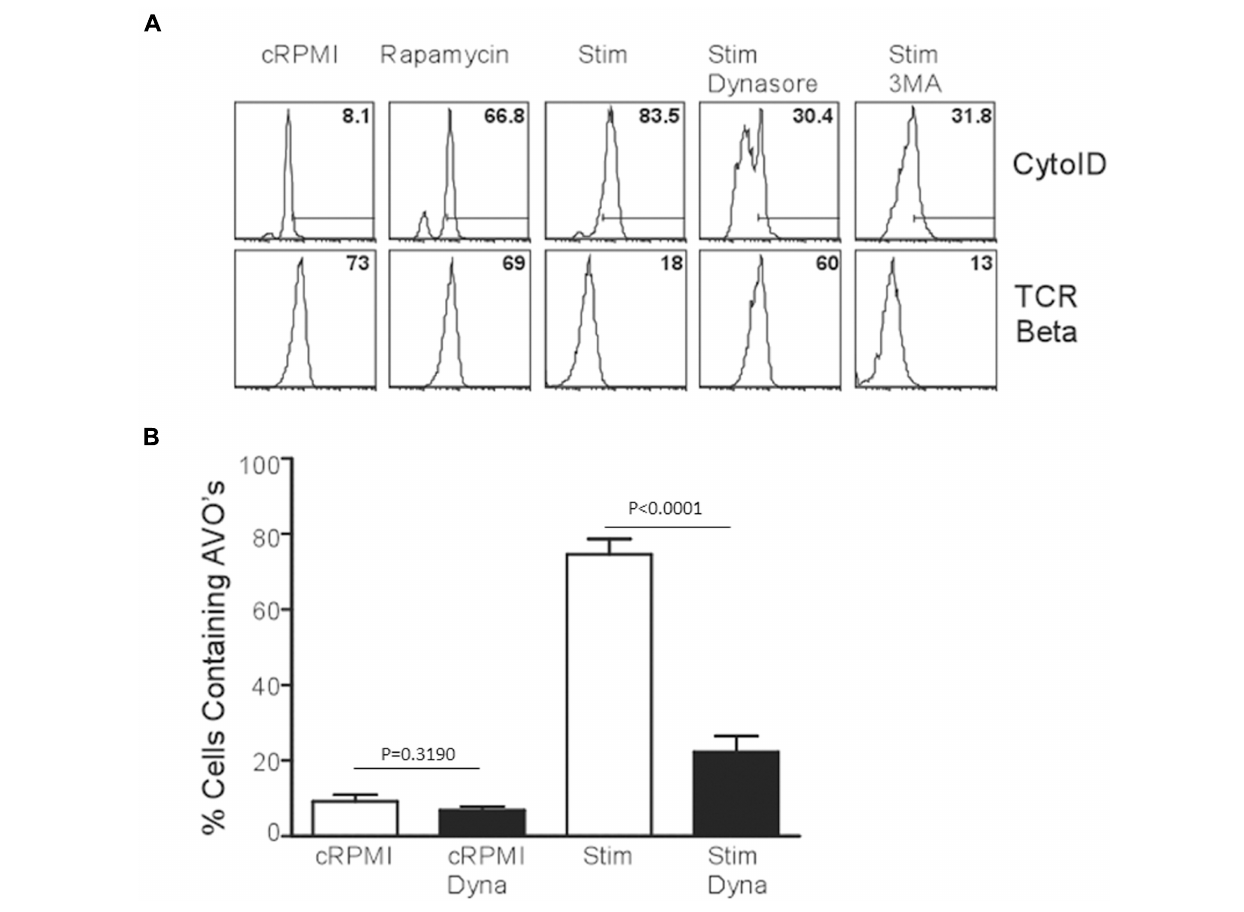
FIGURE 4 | TCR internalization is required for TCR-mediated autophagy induction. (A) AVO formation in CD4 T cells pre-treated with 100 µ M Dynasore or 5 mM 3MA for 1 h and stimulated for 24 h with 1 µ g/mL soluble anti-CD3 and anti-CD28. Lower panel indicates the relative levels of TCR- β on the cell surface to demonstrate the efficacy of Dynasore versus other treatments. (B) Quantification of AVO formation in (A) , data represents 3 independent